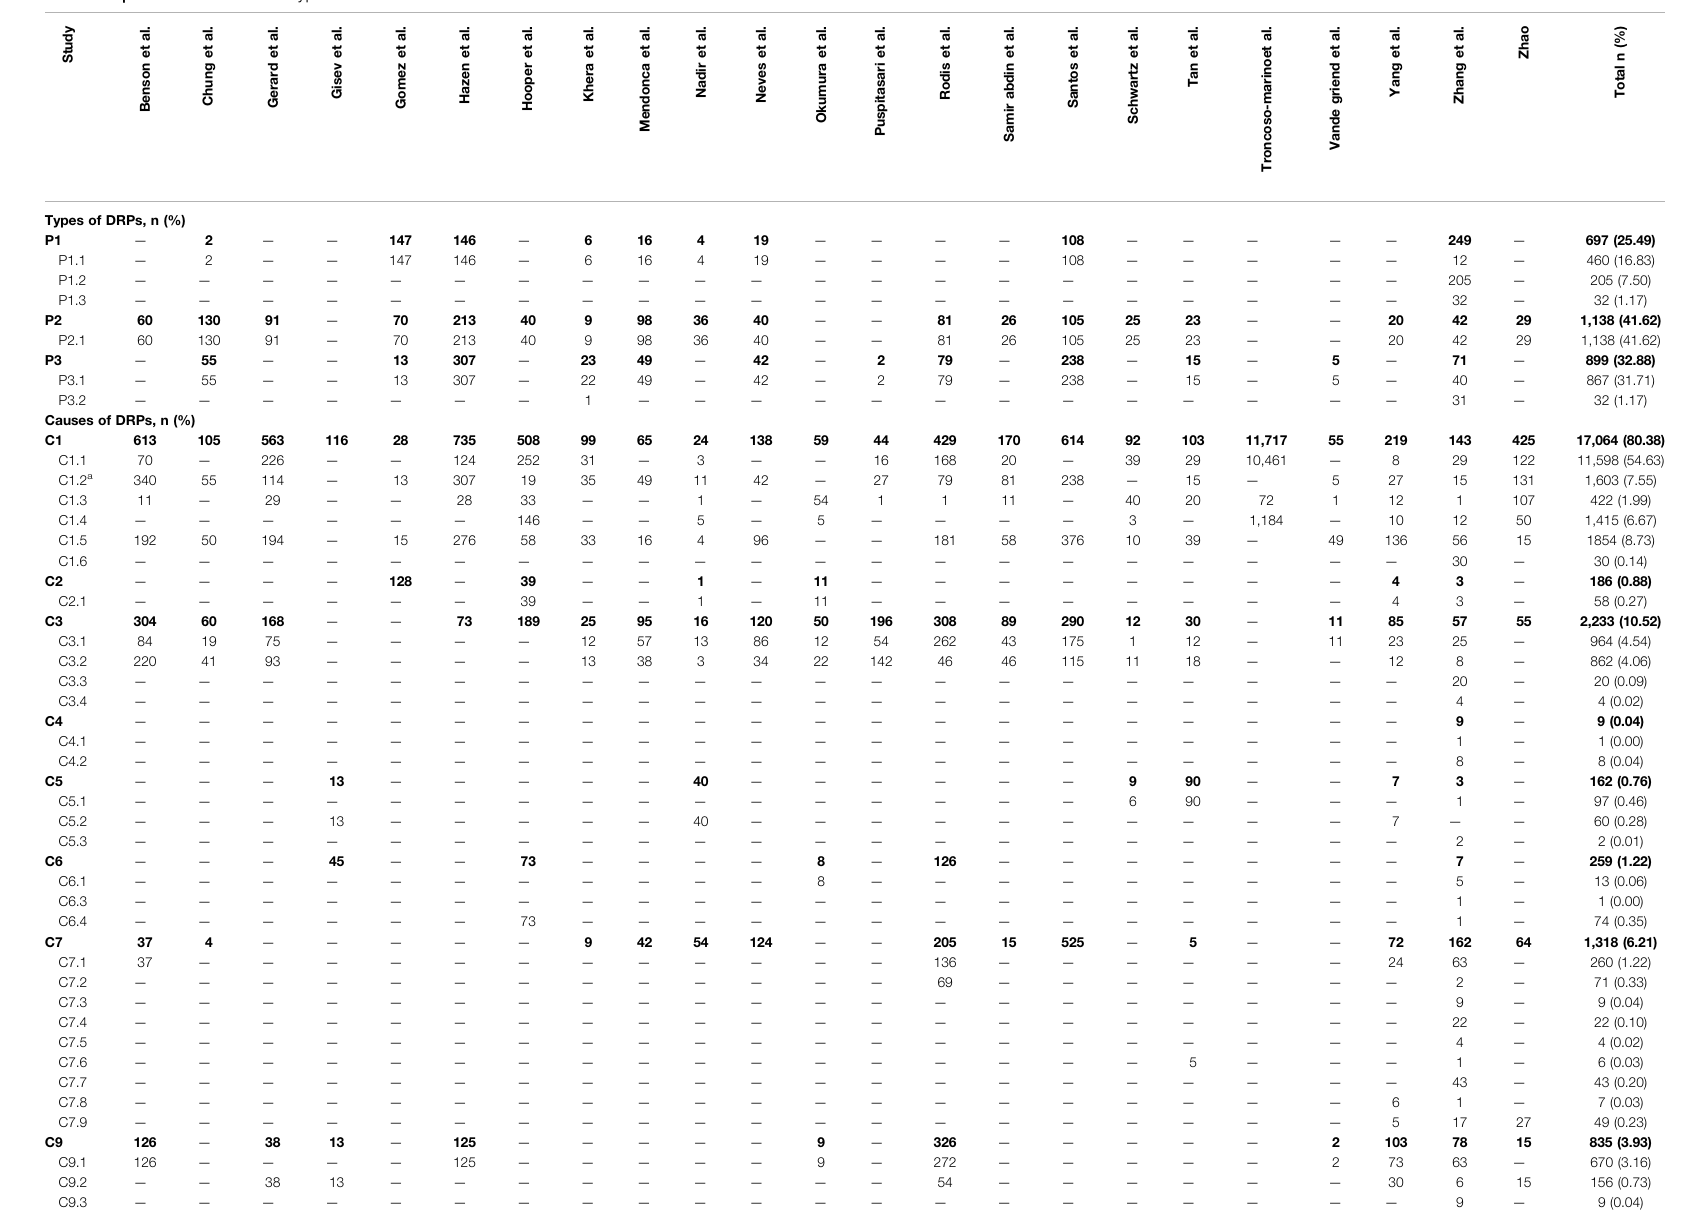
TABLE 4 | The classi fi cations of types and causes of DRPs of included studies.